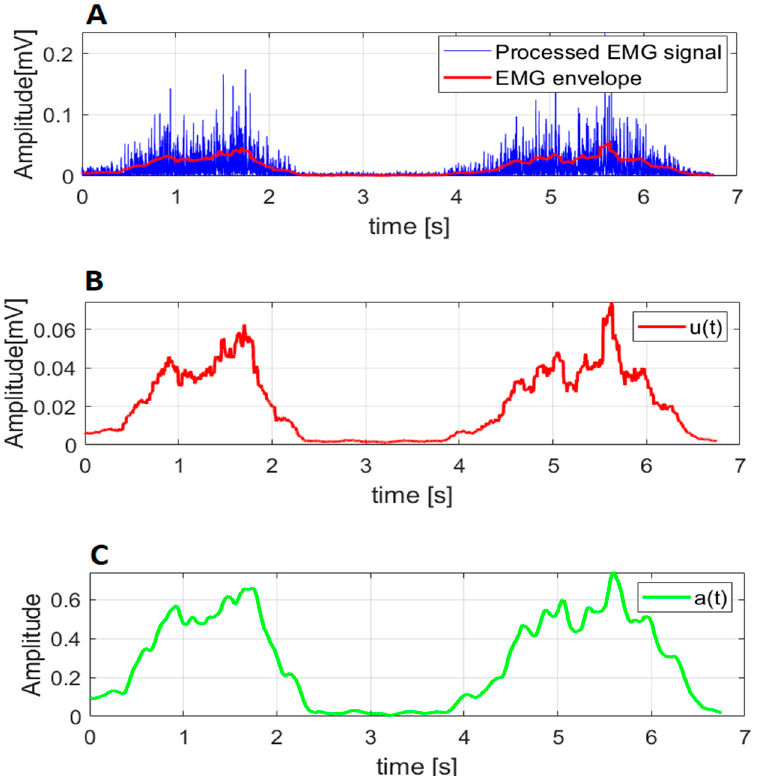
Figure 2. Muscle activation estimation: ( A ) Processed EMG signal (blue line) and EMG envelope (red line); ( B ) neural activation u ( t ) ; ( C ) muscle activation a ( t ) obtained using Equation (1).